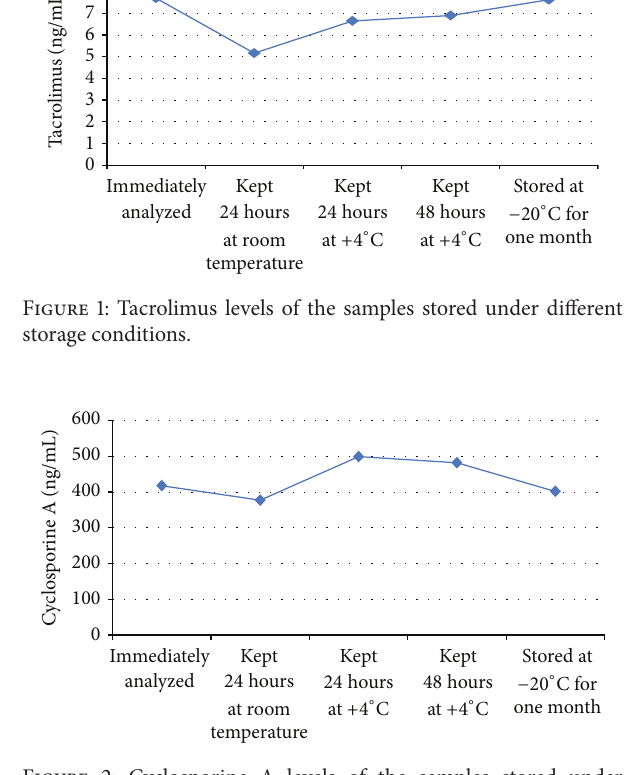
Figure 2: Cyclosporine A levels of the samples stored under different storage